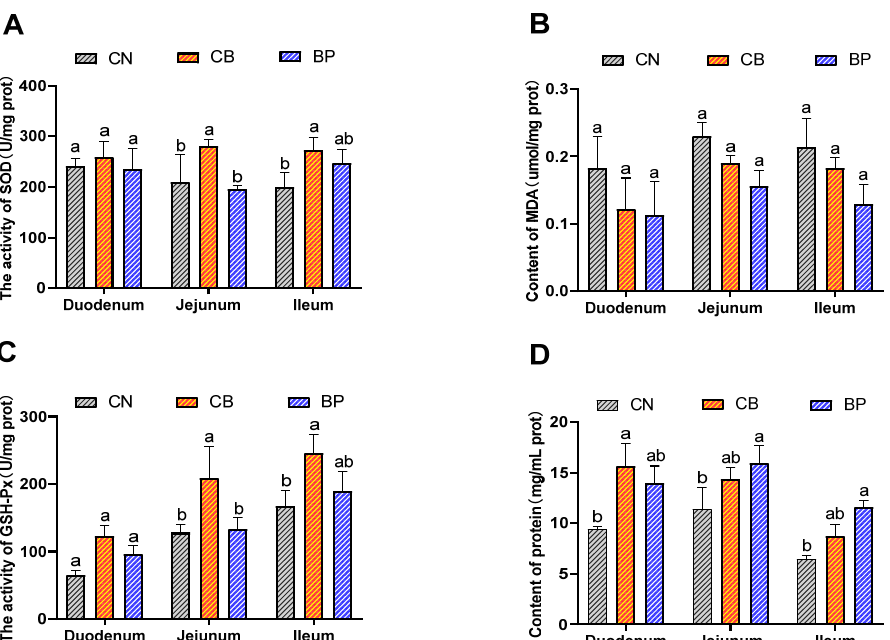
Figure 3. Effects of CN, CB, and BP on antioxidant enzyme activity in weaning rabbits. ( A – D ) SOD and GSH-Px activity, protein activity and MDA content in small intestinal tissues. CN, rabbits were fed a basal diet; CB, rabbits were fed a basal diet supplemented with Clostridium butyricum ; BP, rabbits were fed a basal diet supplemented with a bacteriophage cocktail (values are expressed as the mean ± SE, n = 8; a,b Mean values within a row with unlike superscript letters were significantly different ( p < 0.05).